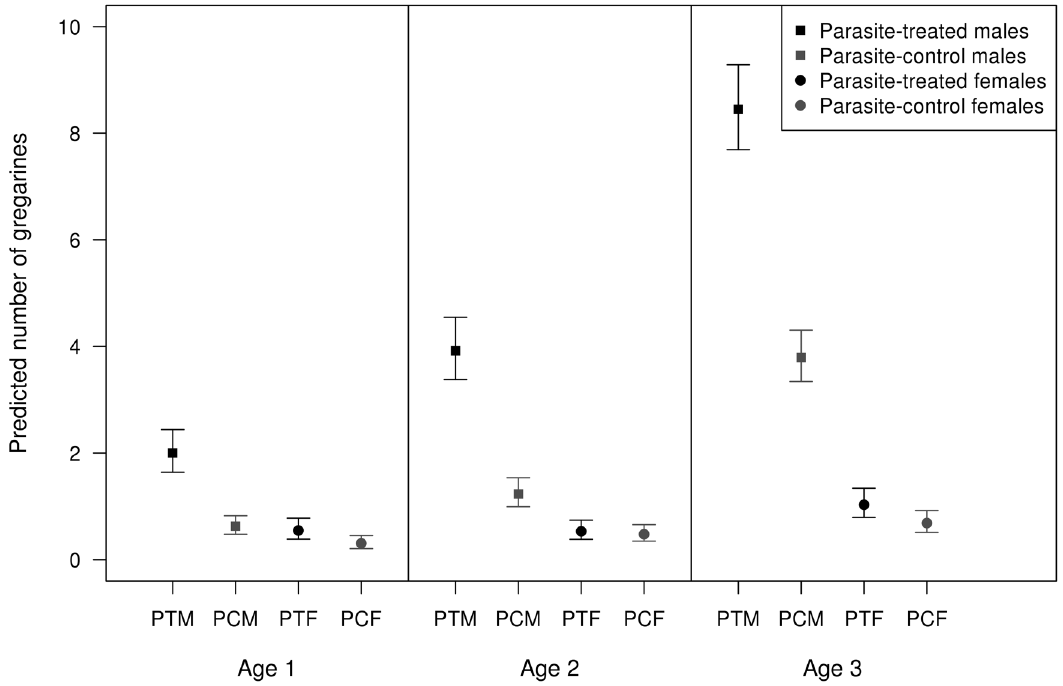
Figure 4. Sex biases in parasitism: experimental data. Predicted gregarine abundance for the experimental study, according to sex, experimental infection and age class. PTM=Parasite-treated males, PCM=Parasite-control males, PTM=Parasite-treated females, PCF=Parasite- control females. Error bars show 95% confidence intervals.